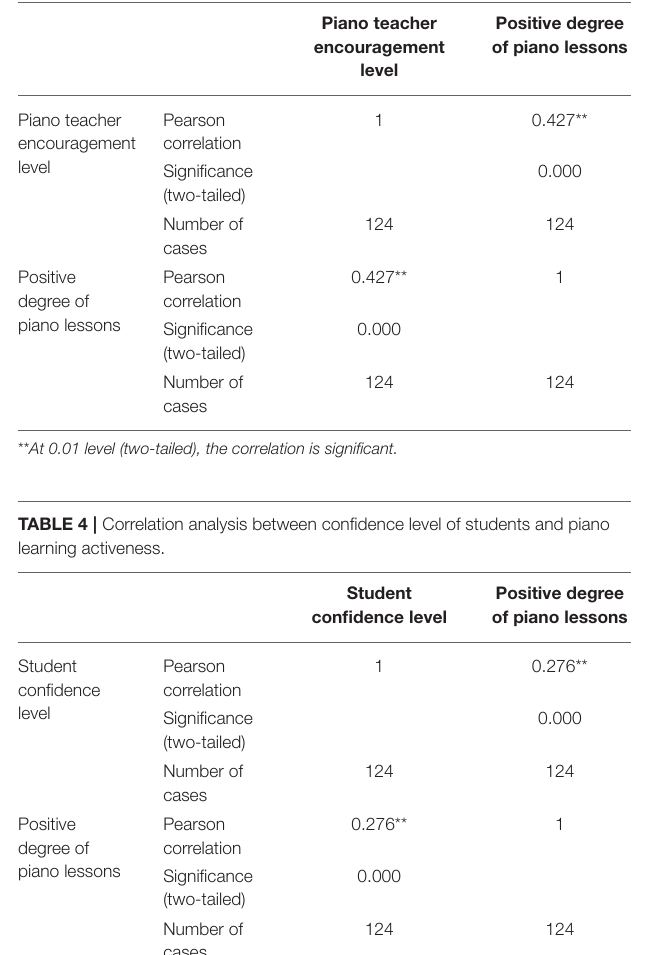
FIGURE 2 | Comparison of piano learning attitudes between groups before and after the experiment in grade 4 (B refers to the experimental group B, B1 refers to the B1 control group, and B2 refers to the B2 control group. − 1, − 2, − 3, − 4, and − 5 refer to the numbers of the five students,